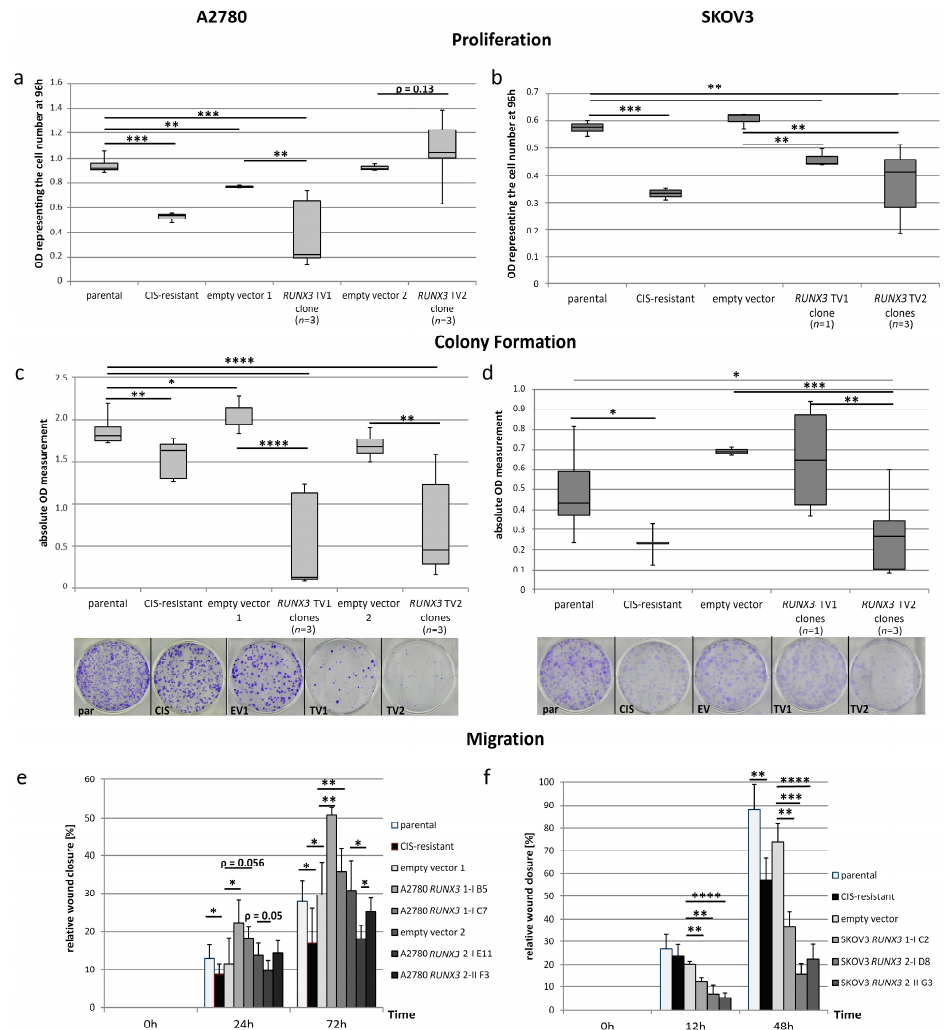
Figure 4. Effects of RUNX3 overexpression on cellular functions. ( a , b ) In A2780 cells, the expression of the two transcript variants resulted in different proliferation rates. While variant 1 led to a high decline, variant 2 caused an increase in the proliferation. In SKOV3 cells the two RUNX3 transcript variants led both to a reduction of proliferation; ( c , d ) The overexpression of RUNX3 transcript variant 1 in A2780 cells led to a reduction while in SKOV3 cells the tested clone showed no change in its colony formation ability. All single cell clones of both cell lines expressing RUNX3 TV2 showed significantly reduced colony formation compared to the parental or control cells. Because of space limitations the exemplary colony formation picture from 6 cm dishes for A2780 empty vector 2 was excluded; ( e ) The overexpression of RUNX3 TV1 in A2780 resulted in a significant increase of migration while a reduction was seen in clones expressing RUNX3 TV2. An overall reduction of migration by 14.8% was seen compared to the control cells; ( f ) In SKOV3 cells all tested RUNX3 clones of both variants presented a decreased migratory behavior while the effect of transcript variant 1 was less pronounced. For all subfigures: * p < 0.05, ** p < 0.01, *** p < 0.001, **** p < 0.0001. (Boxplots depict minimum and maximum values (whiskers); the inter quartile range (box) and the median (line). Bar charts depict the mean ±